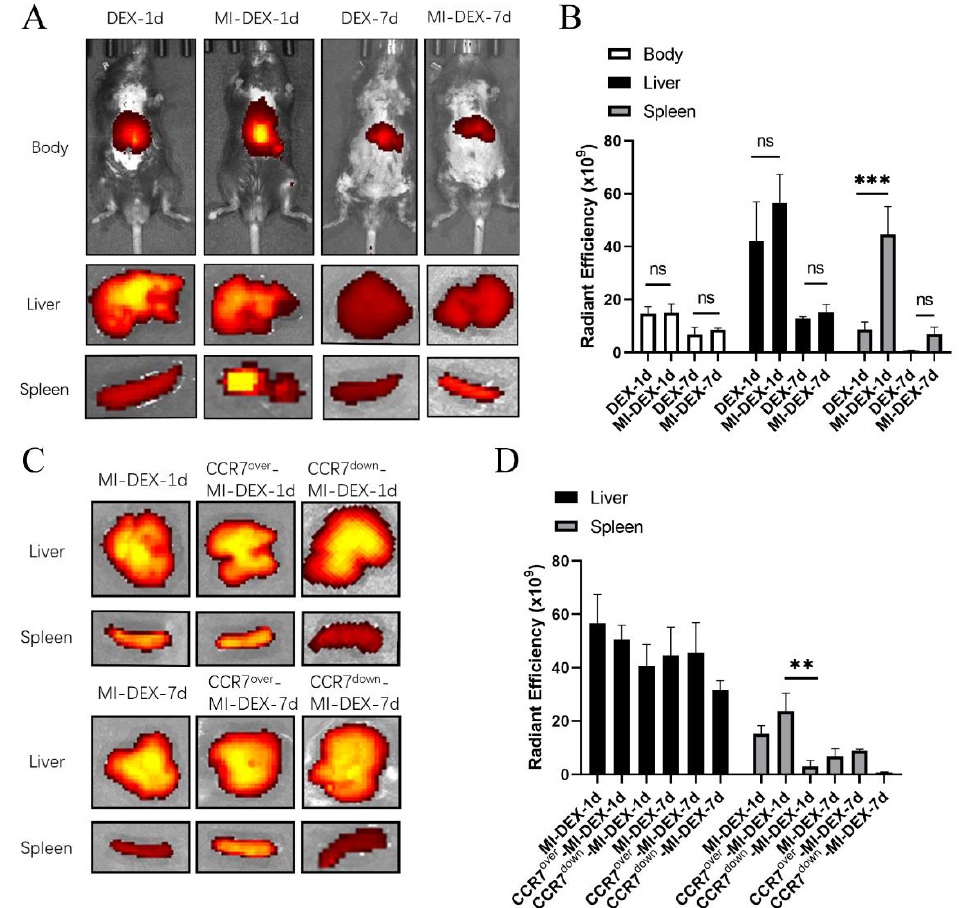
Figure 2. CCR7 mediates MI-DEXs’ migration. Representative near-IR fluorescence images of the main organs and body after DEXs or MI-DEX injections ( A ). Analysis of the radiant efficiency of body, spleen, and liver ( B ). Representative near-IR fluorescence images of the liver and spleen after different MI-DEXs injections ( C ). Analysis of the radiant efficiency of the liver and spleen after different MI-DEX injections ( D ). n = 3, * p < 0.05, ** p < 0.01, *** p < 0.001.